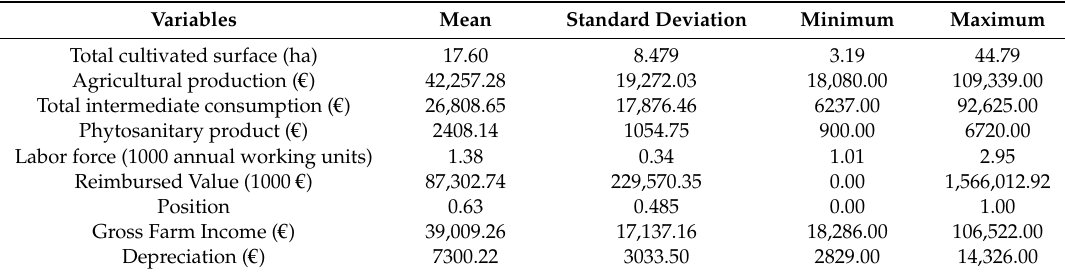
Table 2. Summary